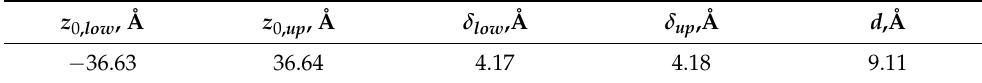
Table 1. The values of the fitted transition region parameters for left- and right-side interfaces. z 0 , low , Å z 0 , up , Å δ low ,Å δ up ,Å d ,Å − 36.63 36.64 4.17 4.18 9.11